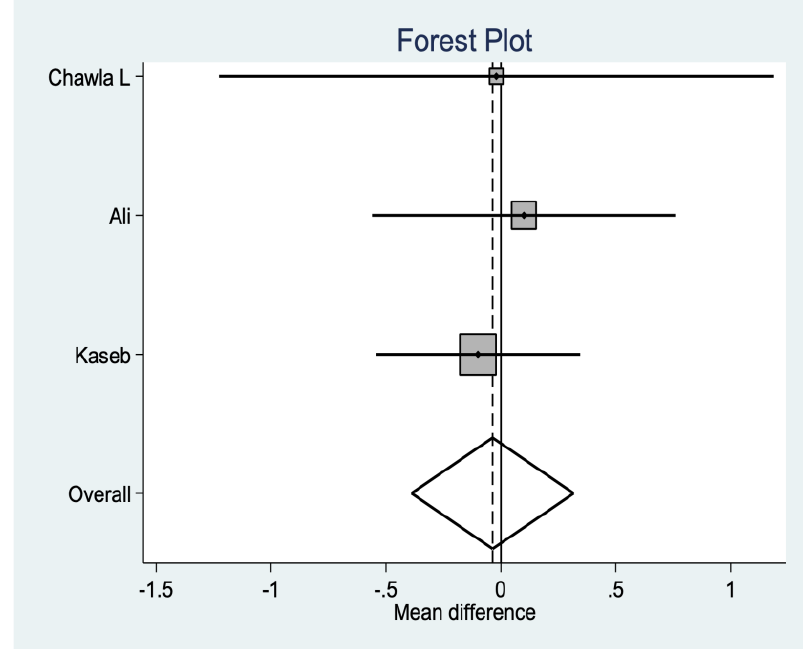
Figure 7. Review fee data.